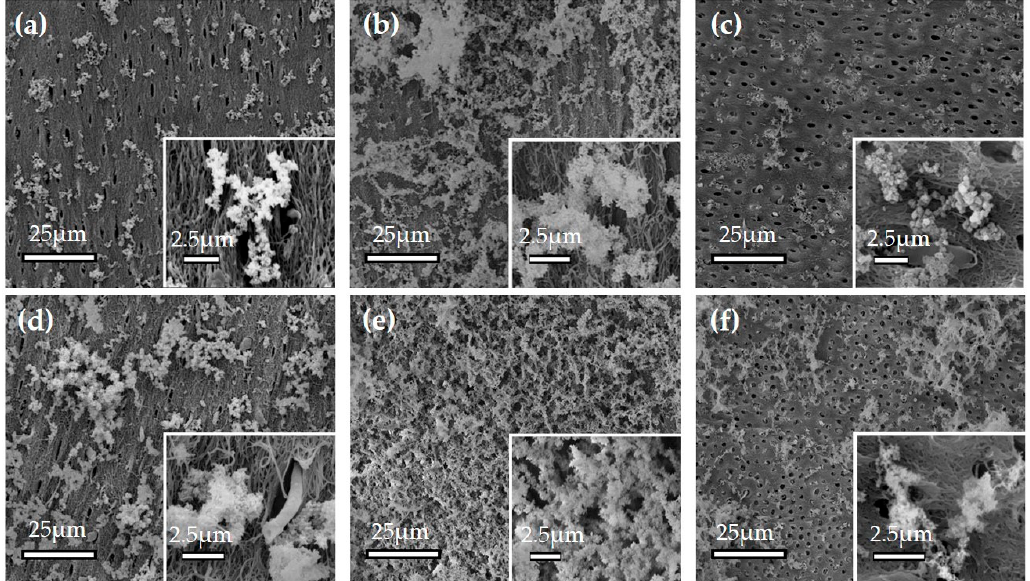
Figure 1. SEM image of the calcium phosphate precipitate with biomaterials. ( a ) Precipitate from 4.86 mM calcium and 2.71 mM phosphate without biomaterials; ( b ) 4.86 mM calcium and 2.71 mM phosphate with 0.025% oxidized low-density lipoprotein (ox-LDL); ( c ) 4.86 mM calcium and 2.71 mM phosphate with 0.025% dextran sulfate; ( d ) 23.66 mM calcium and 13.18 mM phosphate without biomaterials; ( e ) 23.66 mM calcium and 13.18 mM phosphate with 0.025% ox-LDL; and ( f ): 23.66 mM calcium and 13.18 mM phosphate with 0.025% dextran sulfate.